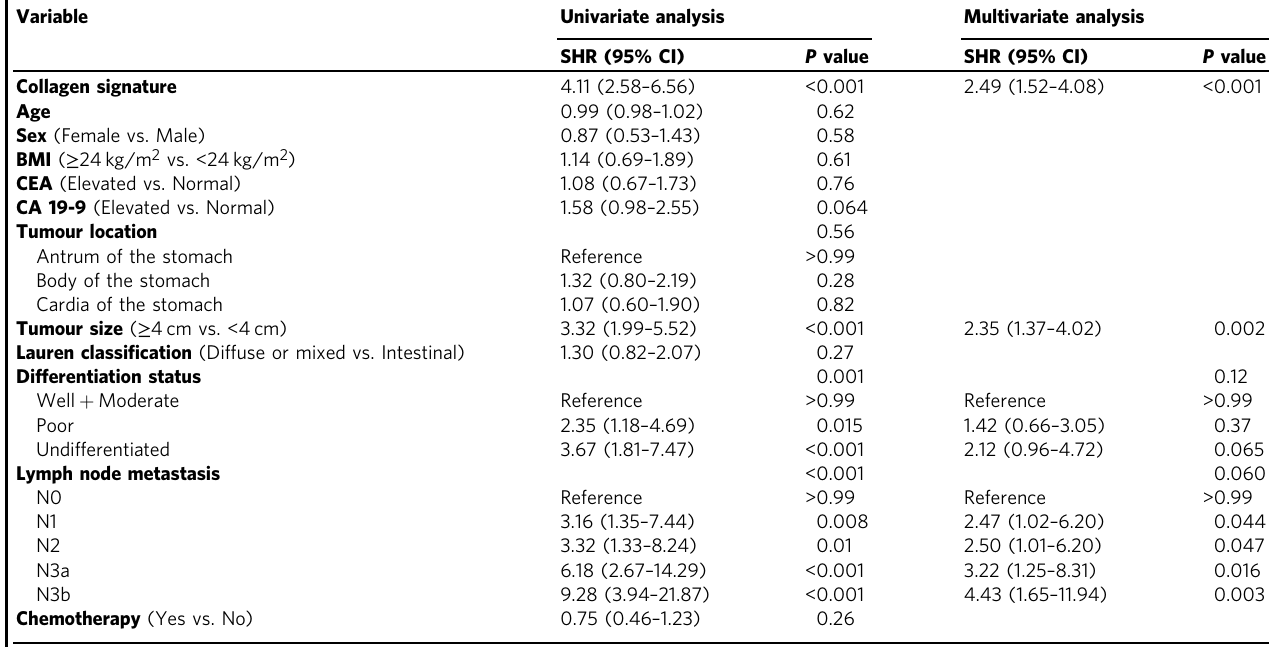
Table 2 Univariate and multivariate Fine-Gray regression in the training